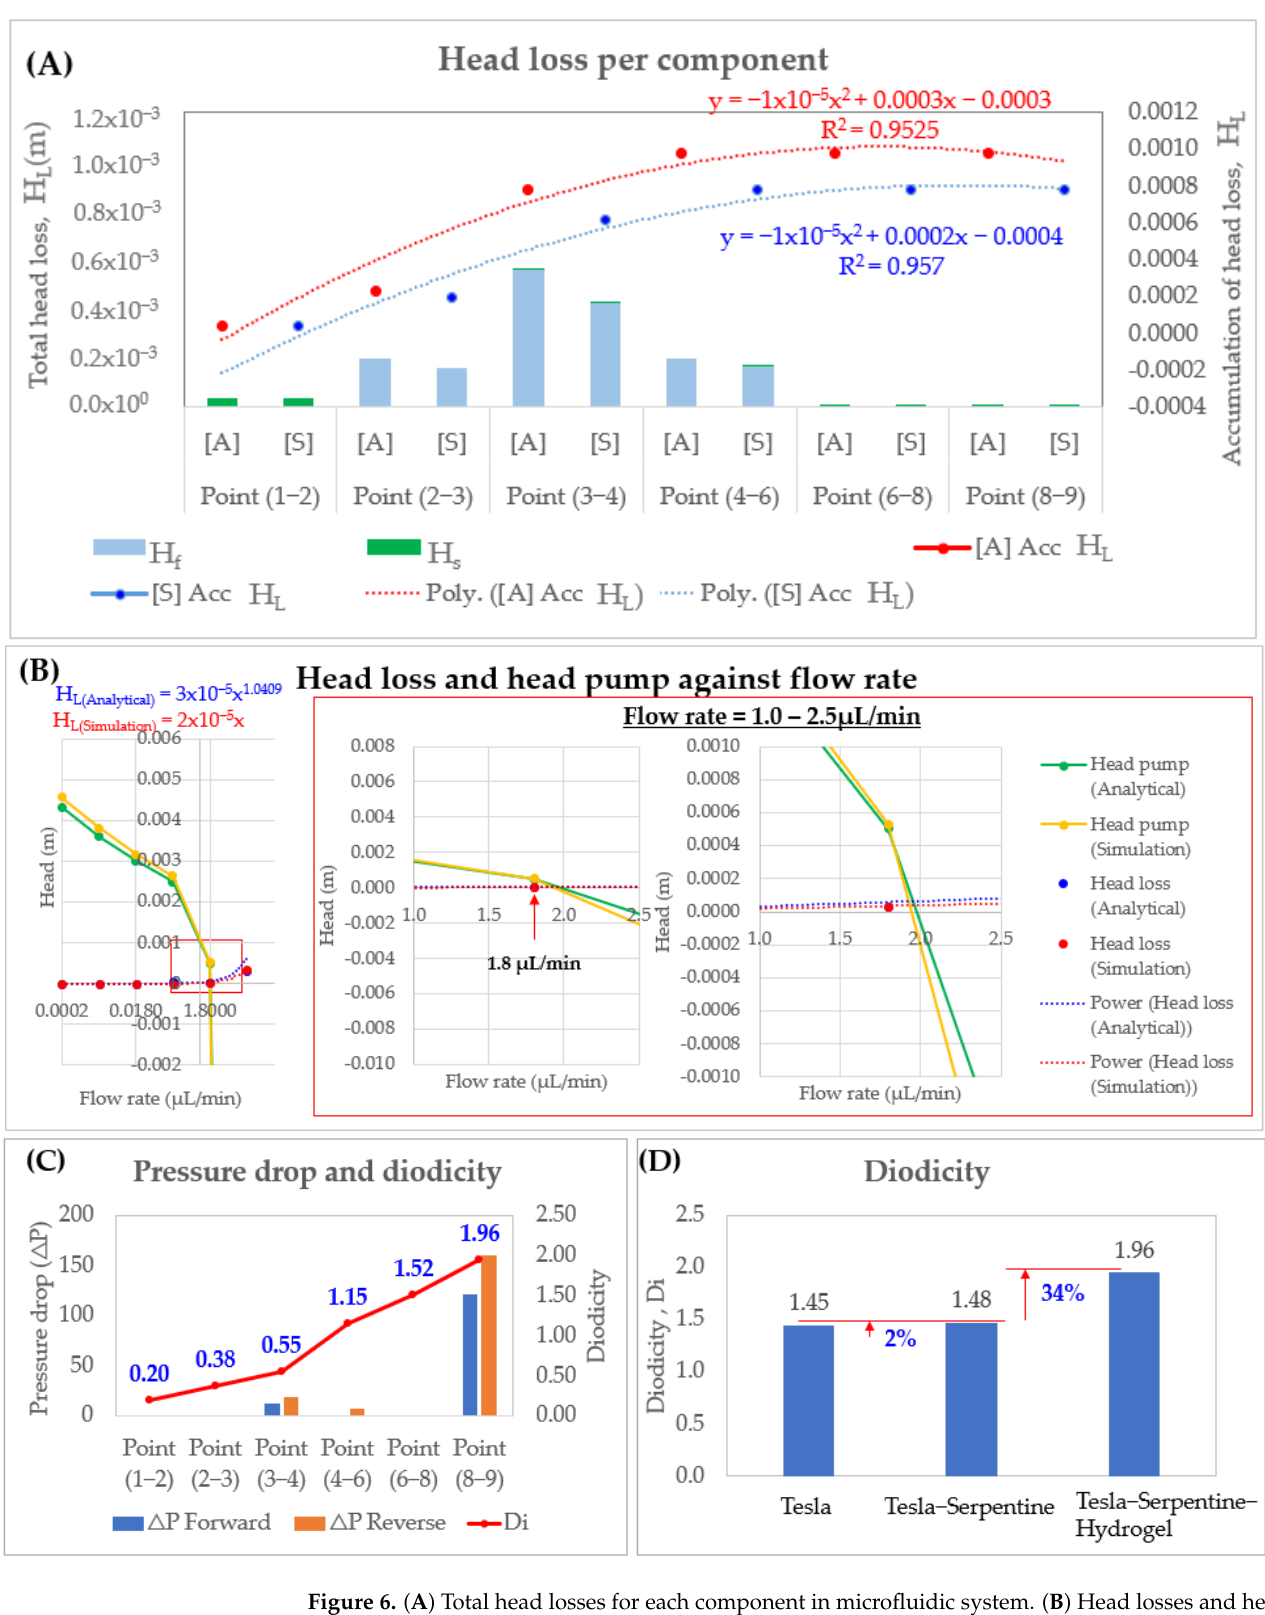
Figure 6. ( A ) Total head losses for each component in microfluidic system. ( B ) Head losses and head pump required against flow rate. (C ) Point-to-point pressure drop and diodicity. ( D ) Diodicity com- parison of Tesla valve, Tesla Serpentine, and Tesla Serpentine-Hydrogel integration in a microfluidic device.